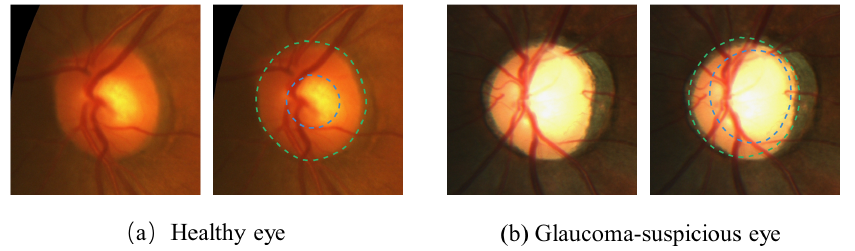
Figure 1. The region enclosed by the green dotted circle is the optic disc (OD); the central bright zone enclosed by the blue dotted circle is the optic cup (OC); and the region between them is the neuroretinal rim. ( a ) An example of a healthy eye. ( b ) An example of a glaucoma-suspicious